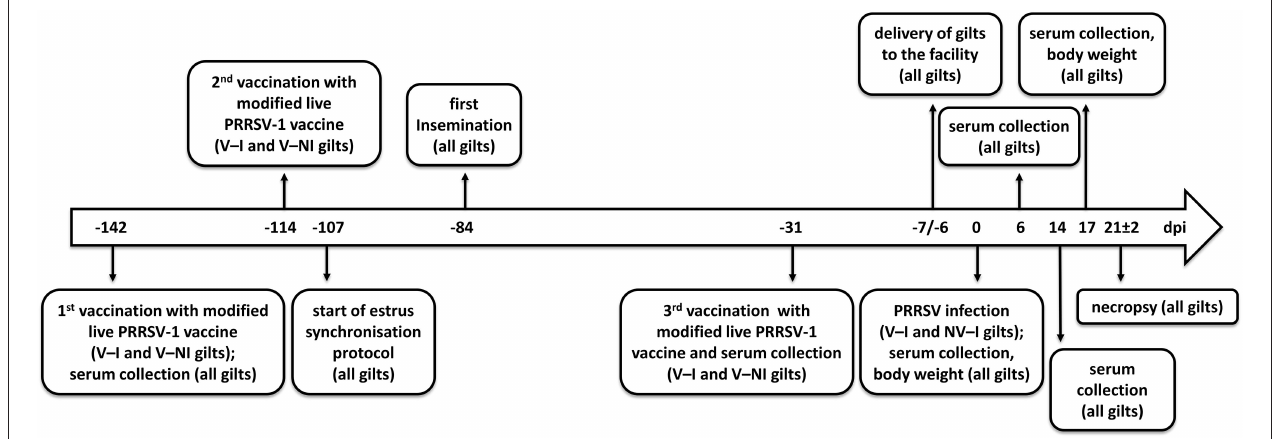
FIGURE 1 | Timeline of events. Days post-infection (dpi) are indicated in the center of the arrow. Eight gilts (V–NI gilts, n = 4; V–I gilts, n = 4) were vaccinated with the modified live PRRSV-1 vaccine ReproCyc ® PRRS EU twice before insemination and once in mid-gestation. Eight other gilts were left unvaccinated (NV–NI gilts, n = 4; NV–I gilts, n = 4). At 1 week before the challenge, the gilts were transported to the biosafety level 2 isolation unit of the University of Veterinary Medicine Vienna. After the challenge with PRRSV-1 strain AUT15-33 (only V–I and NV–I gilts), the samples were collected, the body weight was assessed, and necropsy was performed from all gilts ( n = 16) at 3 weeks after the challenge of the V–I and NV–I gilts. NV–NI, non-vaccinated and non-infected gilts; V–NI, vaccinated and non-infected gilts; V–I, vaccinated and infected gilts; NV–I, non-vaccinated and infected gilts.